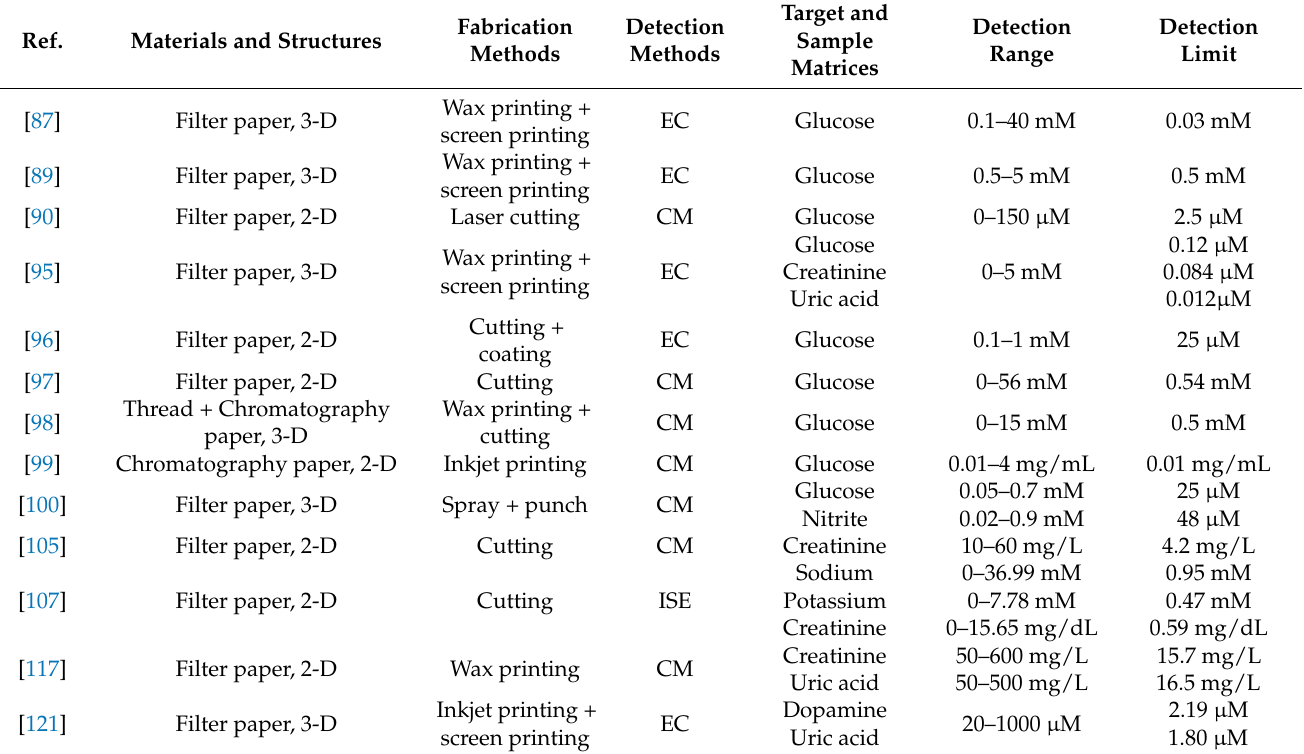
Table 2. Summarizes the µ PADs used for urine